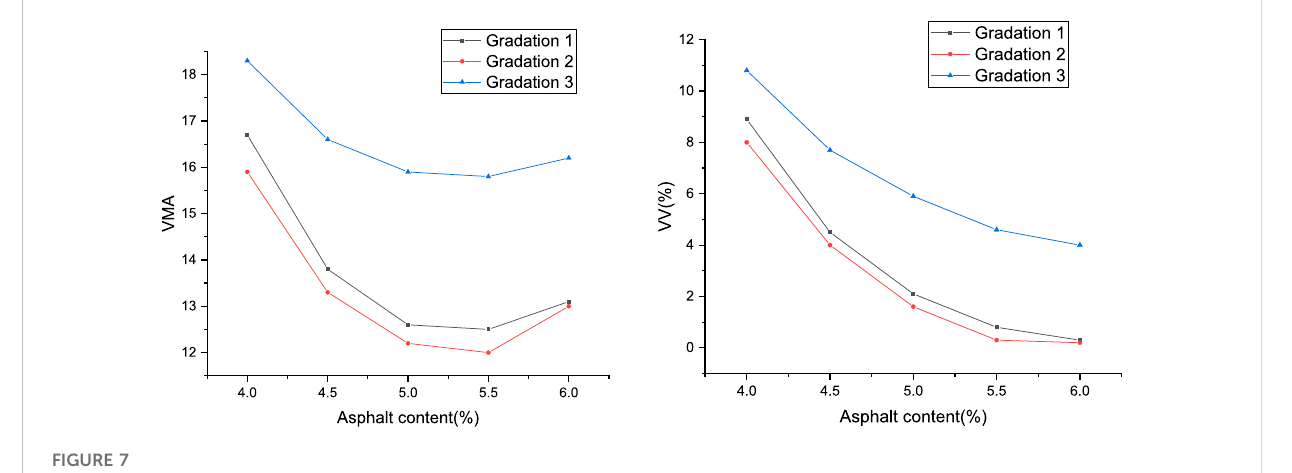
FIGURE 7 elationships among VMA, VV, and asphalt content.